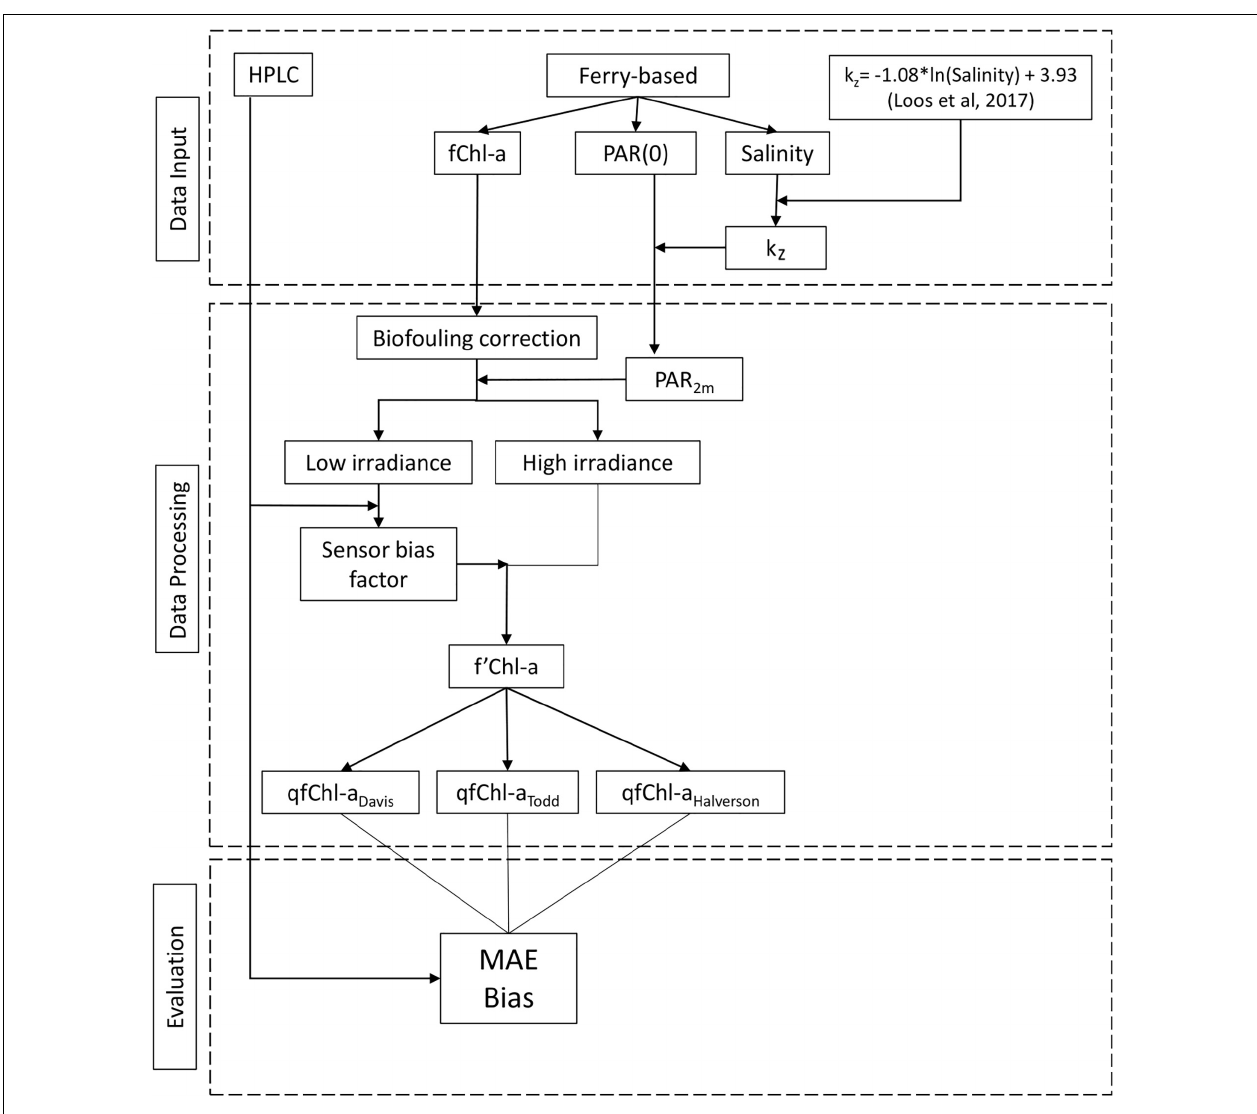
FIGURE 2 | Flowchart showing primary steps in the data analysis, including data inputs, data processing and